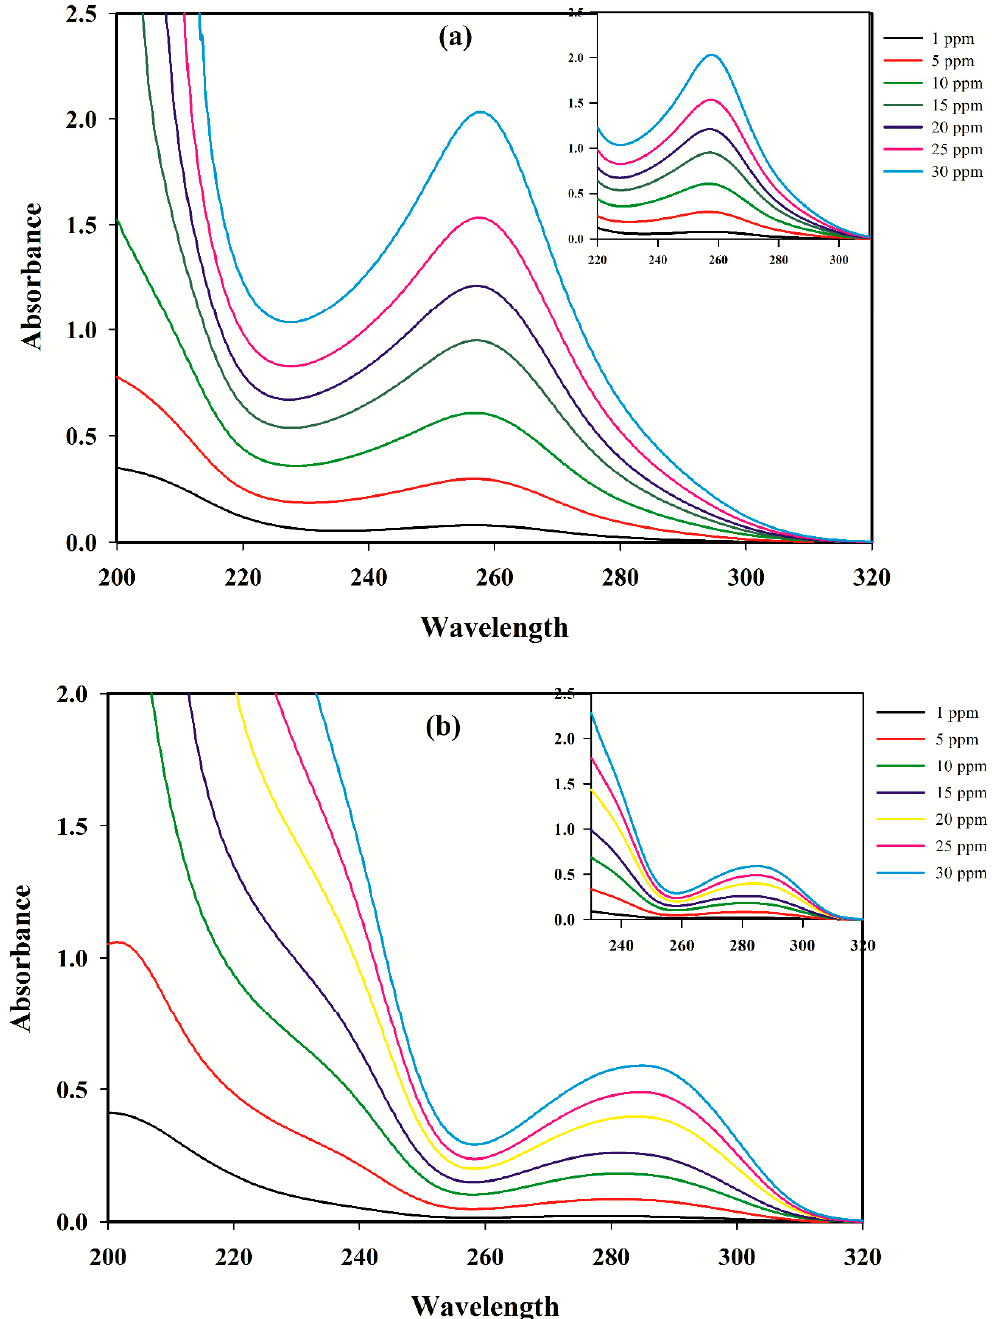
Figure 2. UV absorbance spectra of ( a ) sulfamethoxazole (pH = 5.4) at different concentrations (1–30 µg mL -1 ); and ( b ) trimethoprim (pH = 7.0) at different concentrations (1–30 µg mL -1 ).